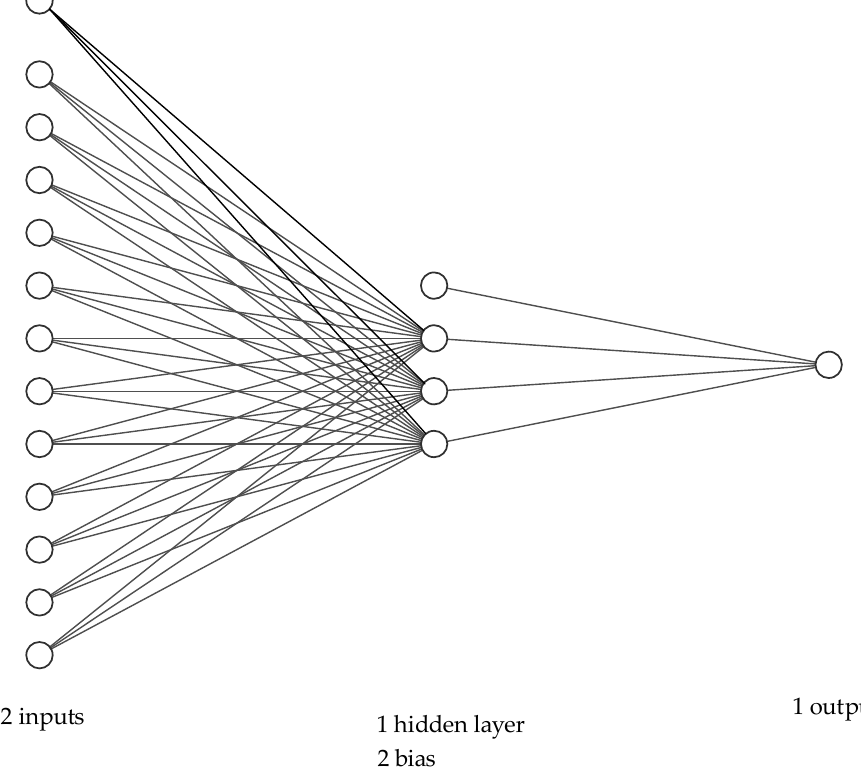
Figure 3. The general representative model with 12 inputs, 1 hidden layer, 2 biases and 1 output.